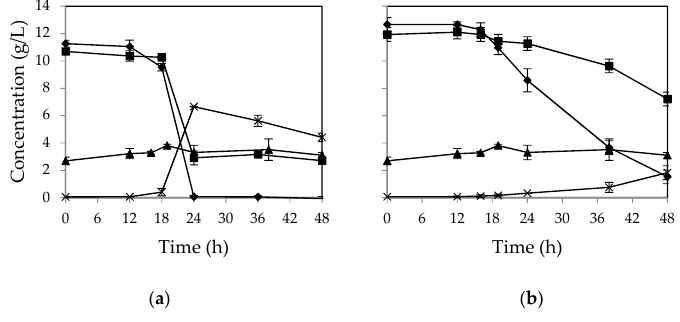
Figure 3. Concentration of ( ▲ ) sucrose, ( ♦ ) glucose, ( ■ ) fructose, and (×) ethanol in ( a ) CWFS supplemented with full nutrients and ( b ) CWFS supplemented with KH 2 PO 4 in baffled shake flasks during the growth of M. indicus . Data are averages of two replicates ± SD.